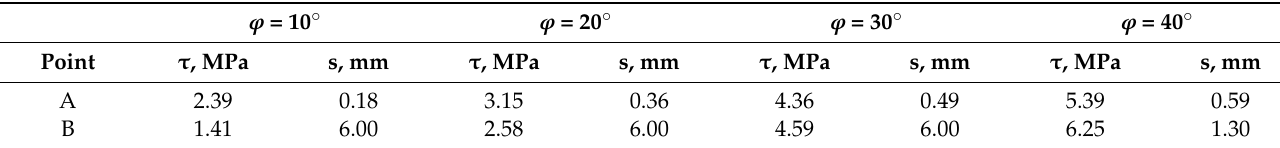
Figure 11. Shear stress–layer slip relationship depending on the value of the friction angle. Table 3. Shear stress and slip values of different friction angle interfaces.